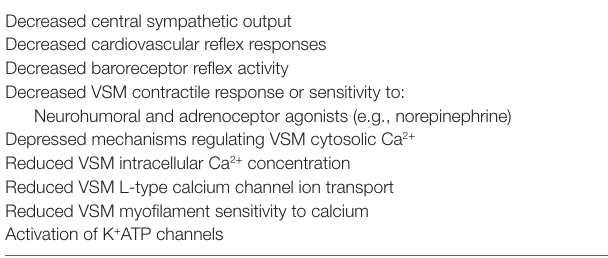
tAbLe 1 | General and cellular mechanisms responsible for anesthesia- associated relative hypovolemia.